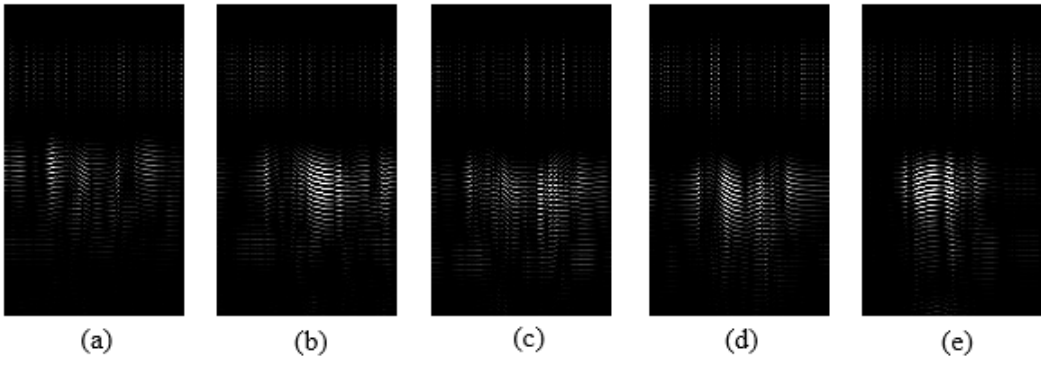
Figure 13. Images corresponding to individual gestures: ( a ) one, ( b ) two, ( c ) three, ( d ) four, and ( e ) five fingers.